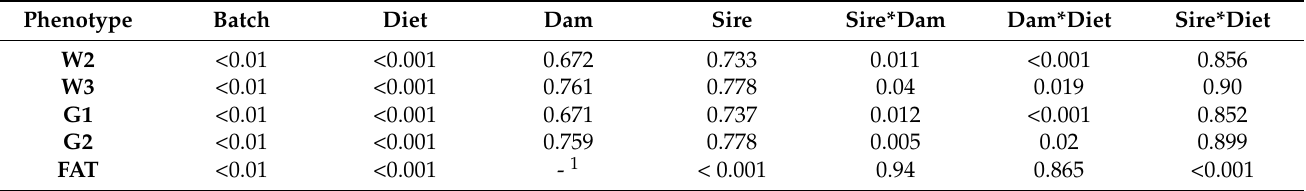
Table 5. Level of significance ( p -values) for the factors included in the linear model for